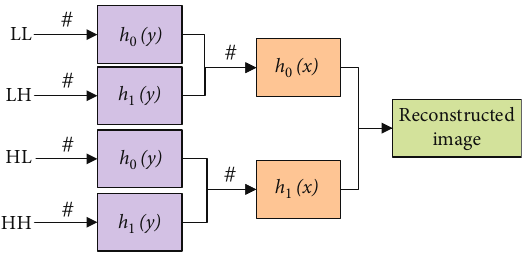
Figure 2: Reconstruction fl ow chart of 2D discrete wavelet decomposition